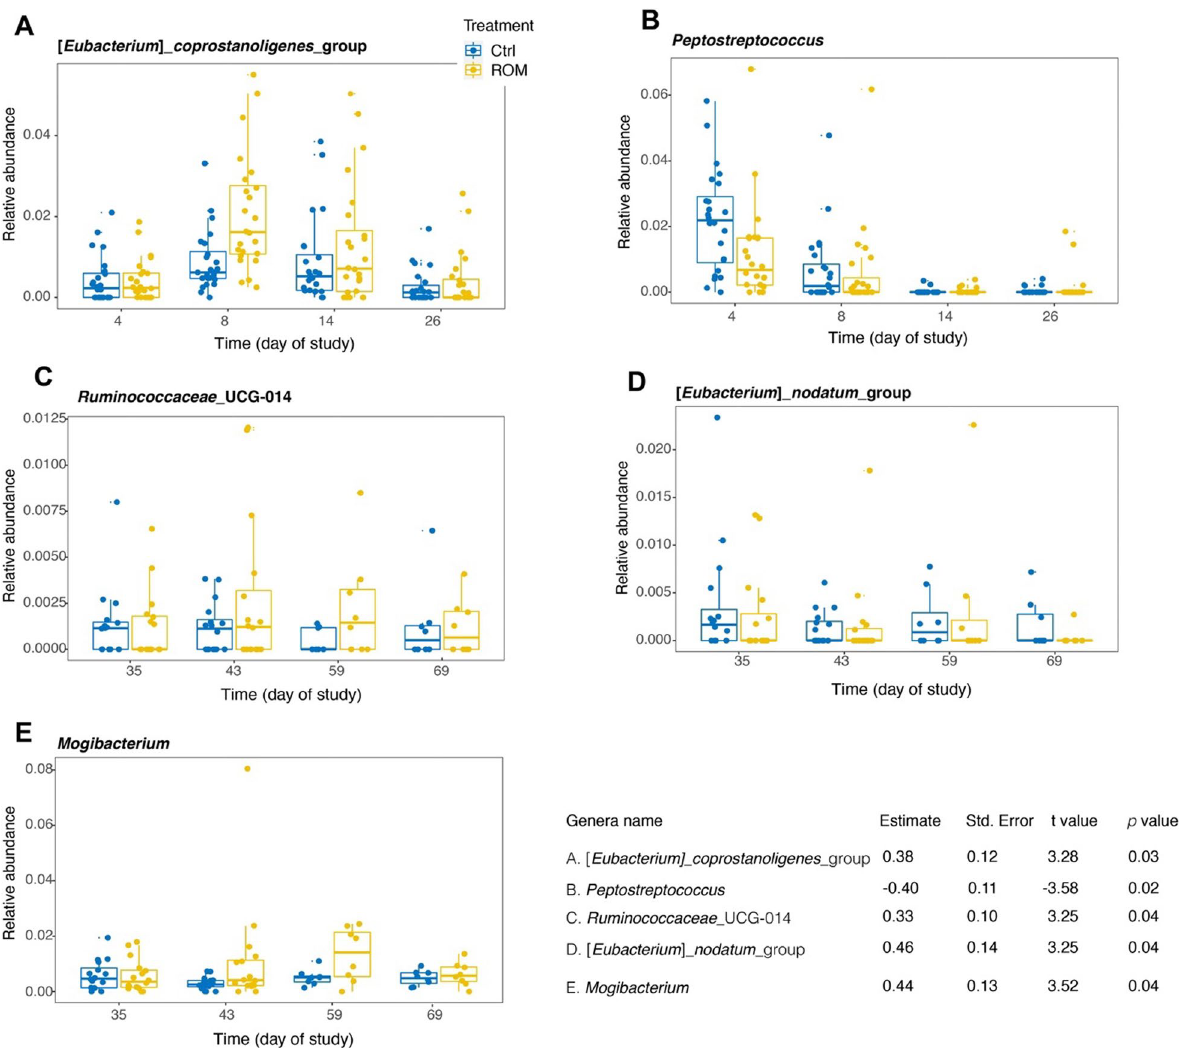
Fig. 3 Differentially abundant genera between ROM and Ctrl pigs during pre‑or post weaning. Plotted genera were identified through GAMLSS‑BEZI model with random effect. The p value was corrected by FDR for multiple testing. Blue and yellow colours represent control (Ctrl) and treated (ROM) groups,